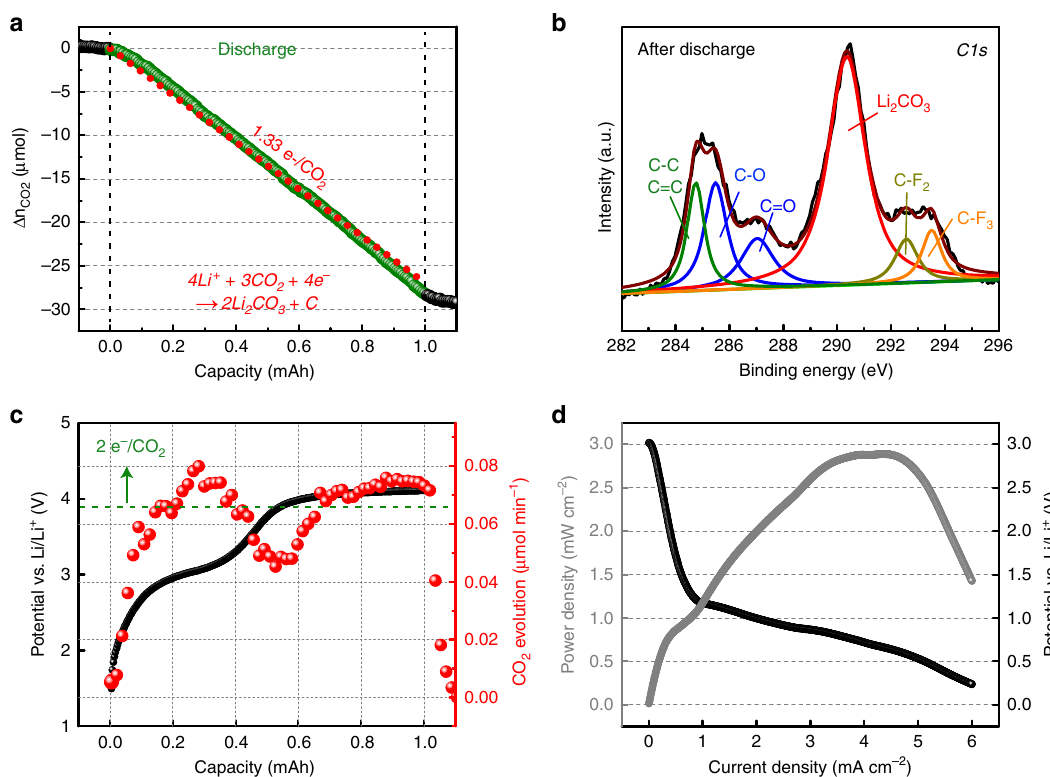
Fig. 1 Electrochemical characterizations of Li – CO 2 cell by using an aprotic electrolyte. a Plot of CO 2 gas consumption during the galvanostatic discharge (200 μ A). The Li – CO 2 cell contains 1 M LiTFSI in TEGDME electrolyte. The red dots indicate the ideal electron-to-CO 2 ratio of 1.33. b C1s XPS result of the carbon cathode after 1-mAh discharge. c Galvanostatic charge plot and the corresponding DEMS results of the Li – CO 2 cell containing 1 M LiTFSI in TEGDME electrolyte. The green dots correspond to the theoretical amount of CO 2 evolution. d Polarization and power-density curves of 1 M LiTFSI in TEGDME with a scan rate of 0.01 mA s − 1